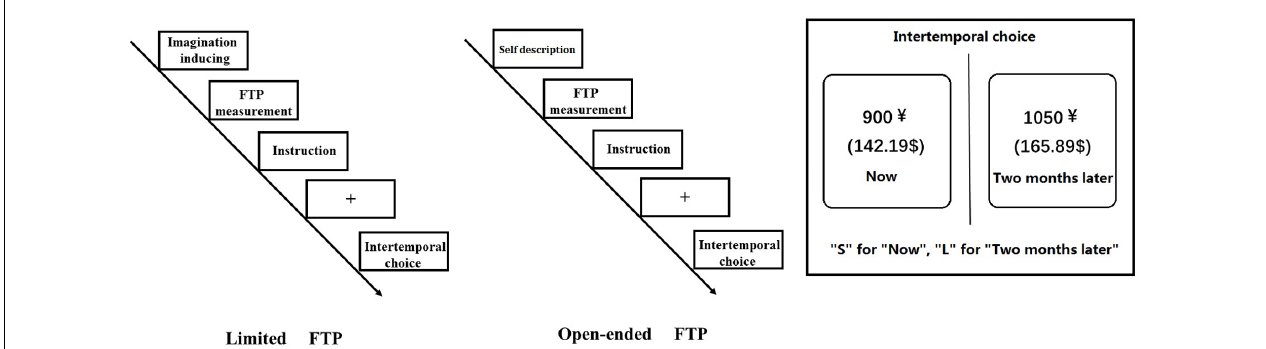
FIGURE 1 | The procedure of the experiment under open-ended vs. limited FTP condition. The choice pairs were presented in random order within the gain/loss condition. The positions (left or right) of the immediate choices and delayed choices were pseudo-randomized, such that the immediate choices were presented on the left side in half of the trials but on the right side in the other half of the trials.